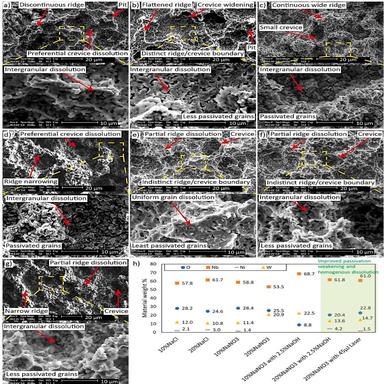
SEM and EDS of the NbC–Ni cermet machined surfaces showing the ridge/crevice dissolution pattern. SEM micrographs at 1000x and 3500x with a) ECM in 10% NaCl, b) ECM in 20% NaCl, c) ECM in 10% NaNO3, d) ECM in 20% NaNO3, e) ECM in 10% NaNO3 with 2.5% NaOH, f) ECM in 20% NaNO3 with 2.5% NaOH and g) LECM in 20% NaNO3. h) Element wt.% distribution of ECM in different electrolytes and LECM in NaNO3 in the 20 × 30 μm yellow marked areas indicating passivation weakening and multiphase dissolution behaviour. (For i